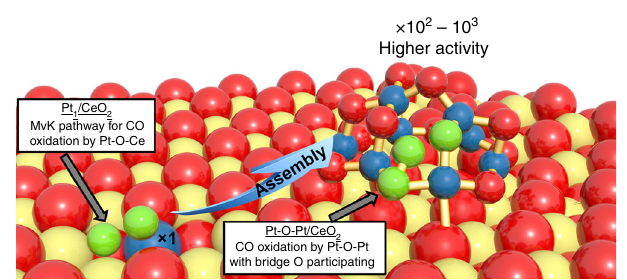
Fig. 6 Different transition states for oxygen activation by the Pt 1 -O-Ce and the Pt-O-Pt ensembles. The detailed con fi gurations for the CO oxidation cycles of the two groups of catalysts are illustrated in Fig. 3. The Pt 1 single atoms are assembled into the more active Pt-O-Pt ensembles during the activation protocol. Color legend of atoms: Ce = yellow; Pt = blue; O = red; O atoms in the transition states for O 2 activation are green. MvK = Mars –